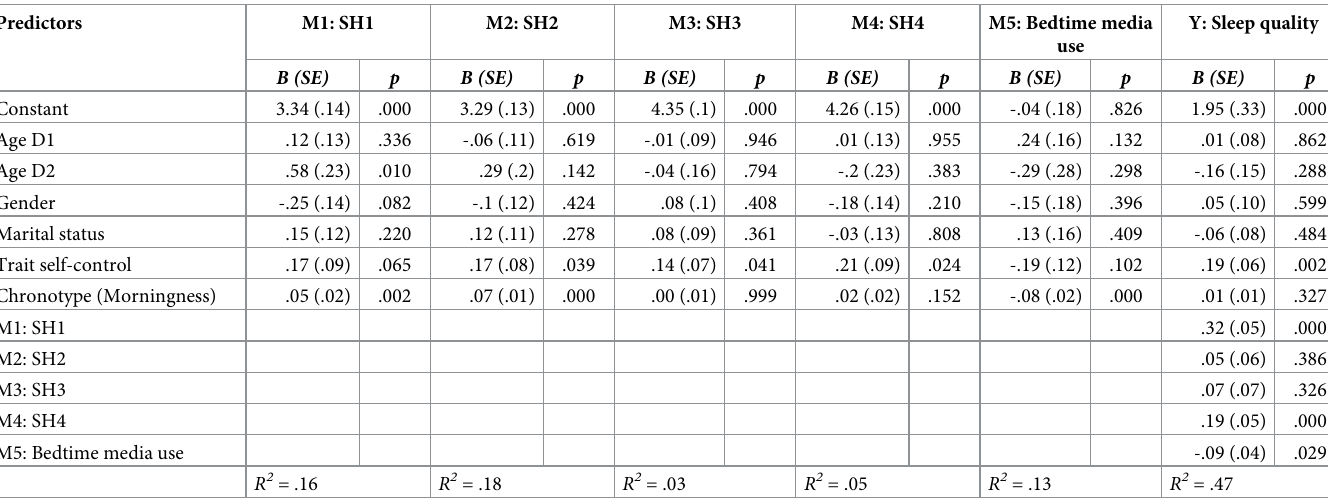
Table 5. Summary of regression coefficients for the multiple mediation